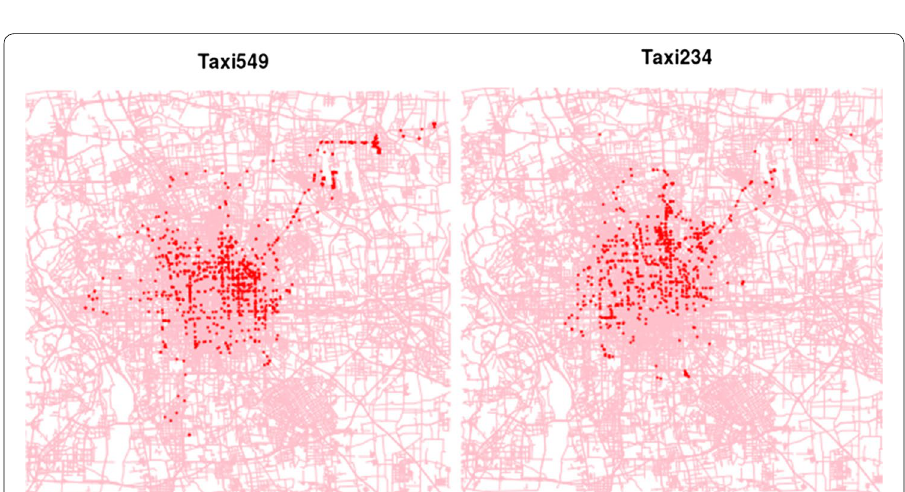
Fig. 12 Spatial distribution of two taxi drivers in Beijing city between 02/02/2008 and 02/08/2008 display at the real map. The pink lines are the read road network. The red dots are the location of